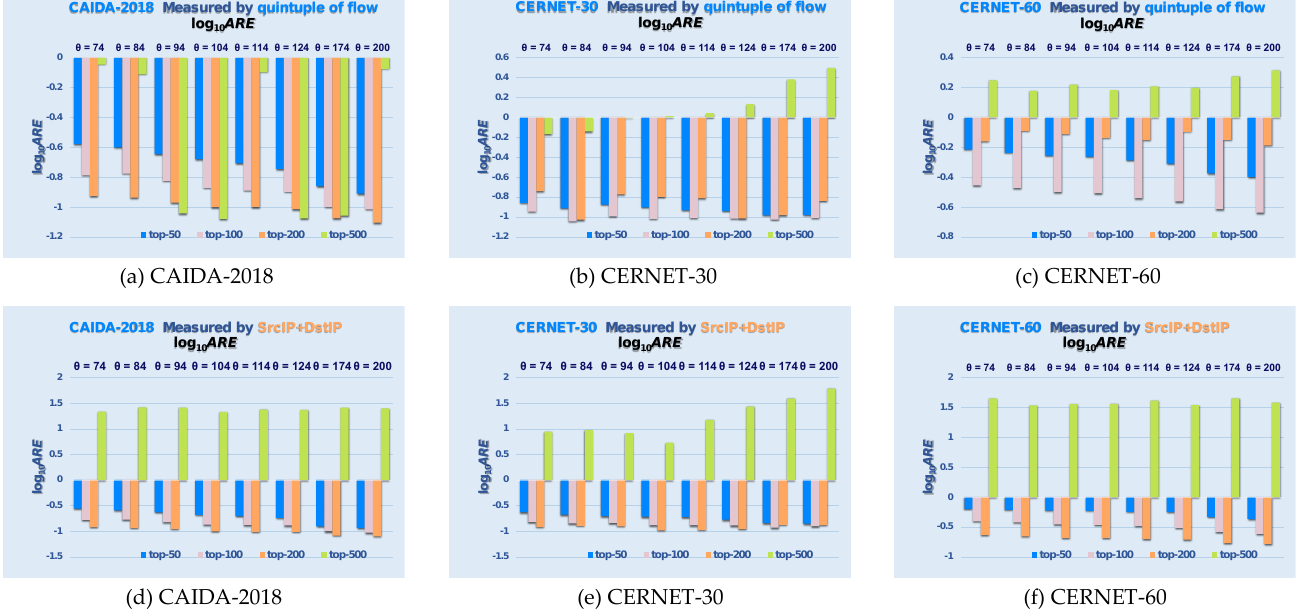
Figure 10. The ARE results of the evaluation. ( a ) The ARE results in CAIDA 2018 by quintuple of flows. ( b ) The ARE results in CERNET-30 by quintuple of flows. ( c ) tThe ARE results in CERNET-60 by quintuple of flows. ( d ) The ARE results in CAIDA 2018 by IP pairs. ( e ) The ARE results in CERNET-30 by IP pairs. ( f ) The ARE results in CERNET-60 by IP